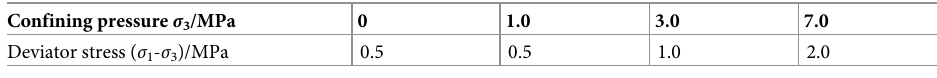
Table 3. Stress loading gradients under different confining pressure.